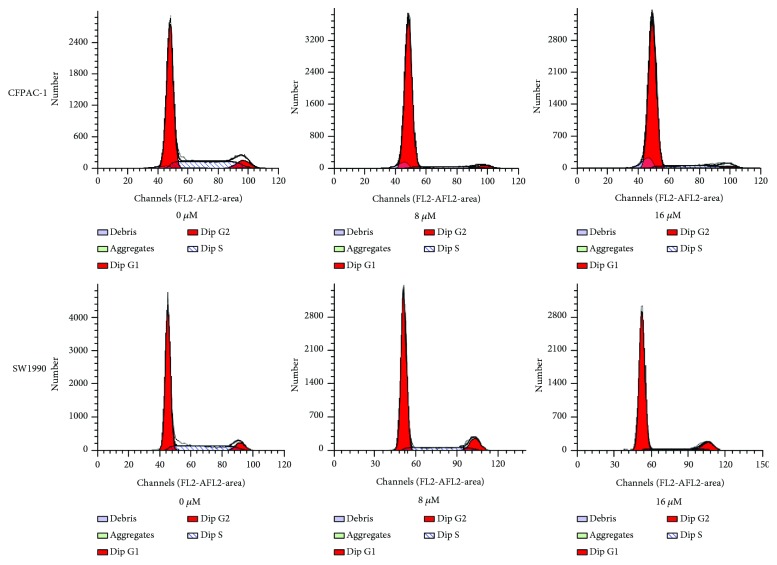
Apatinib promoted cell cycle arrest in a concentration-dependent manner. The cell cycle distributions of the CFPAC-1 and SW1990 cells after treatment with apatinib (0, 8, and 16 μM) for 24 h were determined through flow cytometry. All experiments were performed in triplicate.